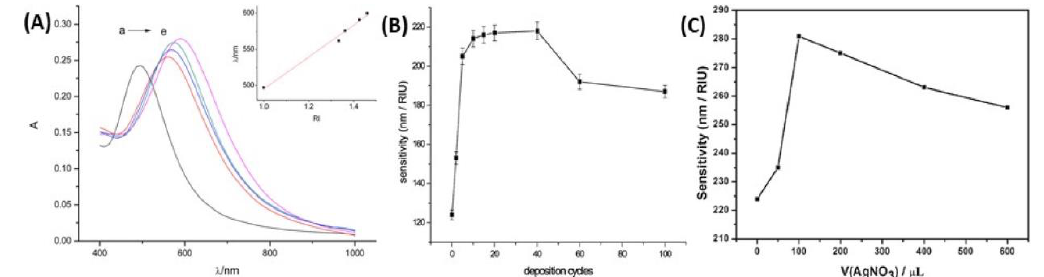
Figure 20. ( A ) Localized surface plasmon resonance (LSPR) band shifts for Ag@Au